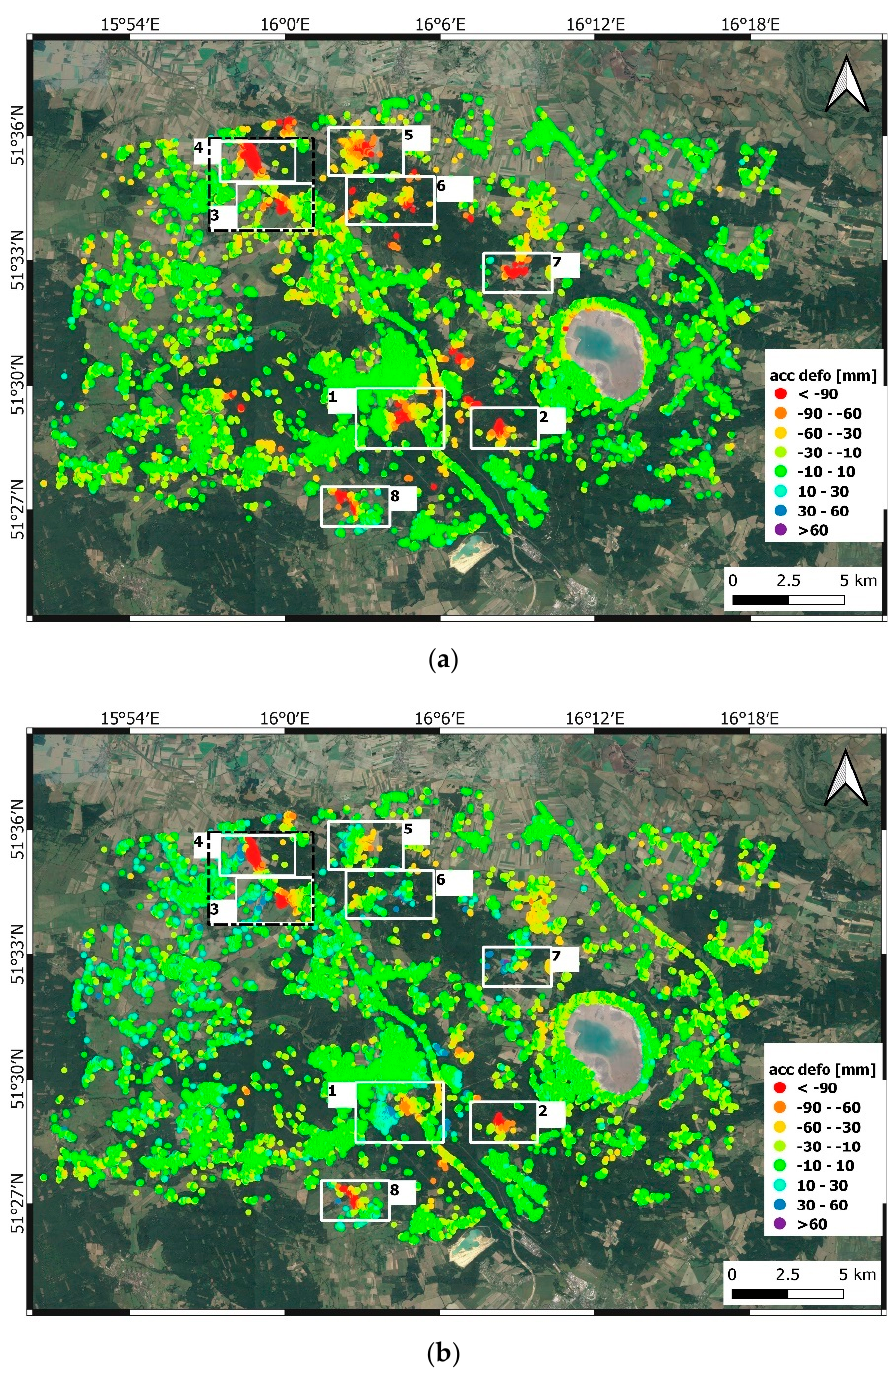
Figure 13. Up-down ( a ) and east-west ( b ) accumulated deformation maps of the area of interest.